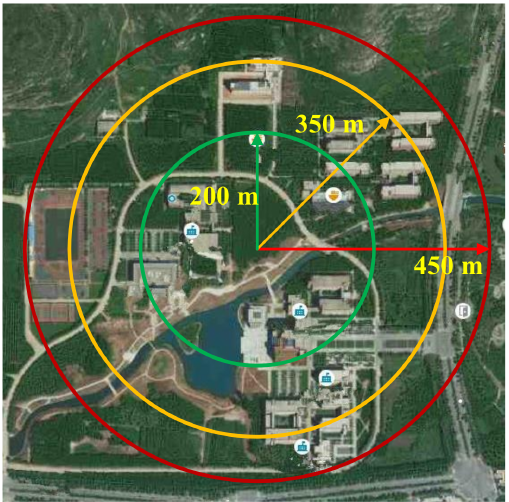
Figure 4. Simulation